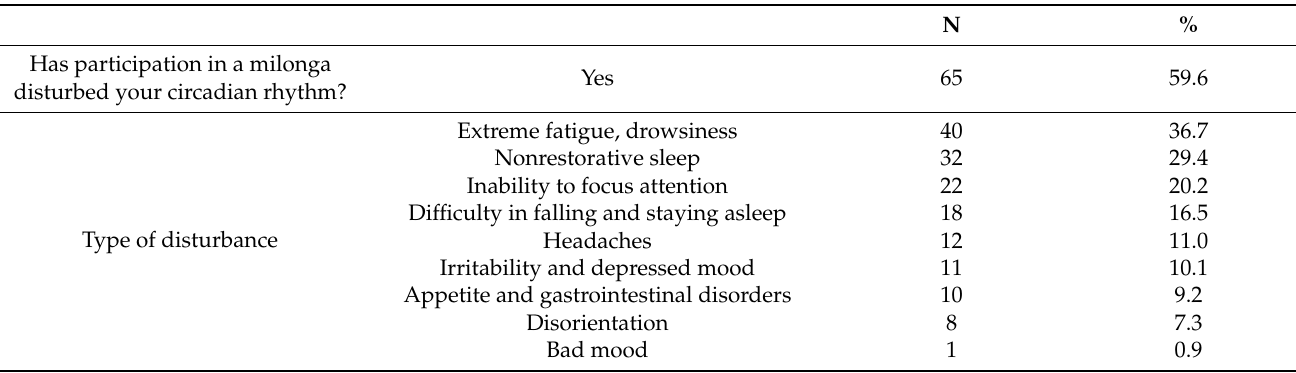
Table 5. Disturbances in the circadian rhythm after participating in a milonga and the percentage of women who took a break from the intensity of AT; N—number of dancers who declared a disturbance, %—percentage of dancers. N % Has participation in a milonga Yes 65 59.6 disturbed your circadian rhythm?